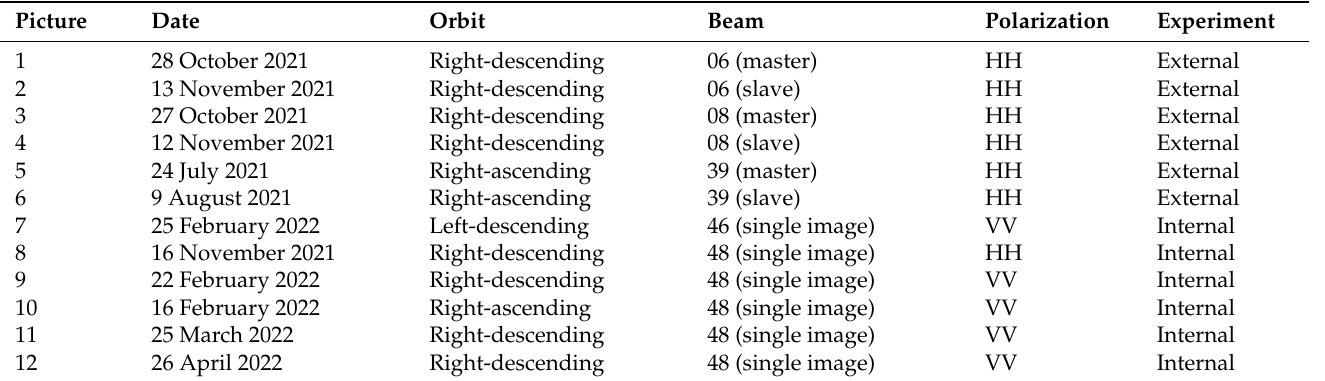
Table 2. List of processed COSMO-Sky-Med SAR